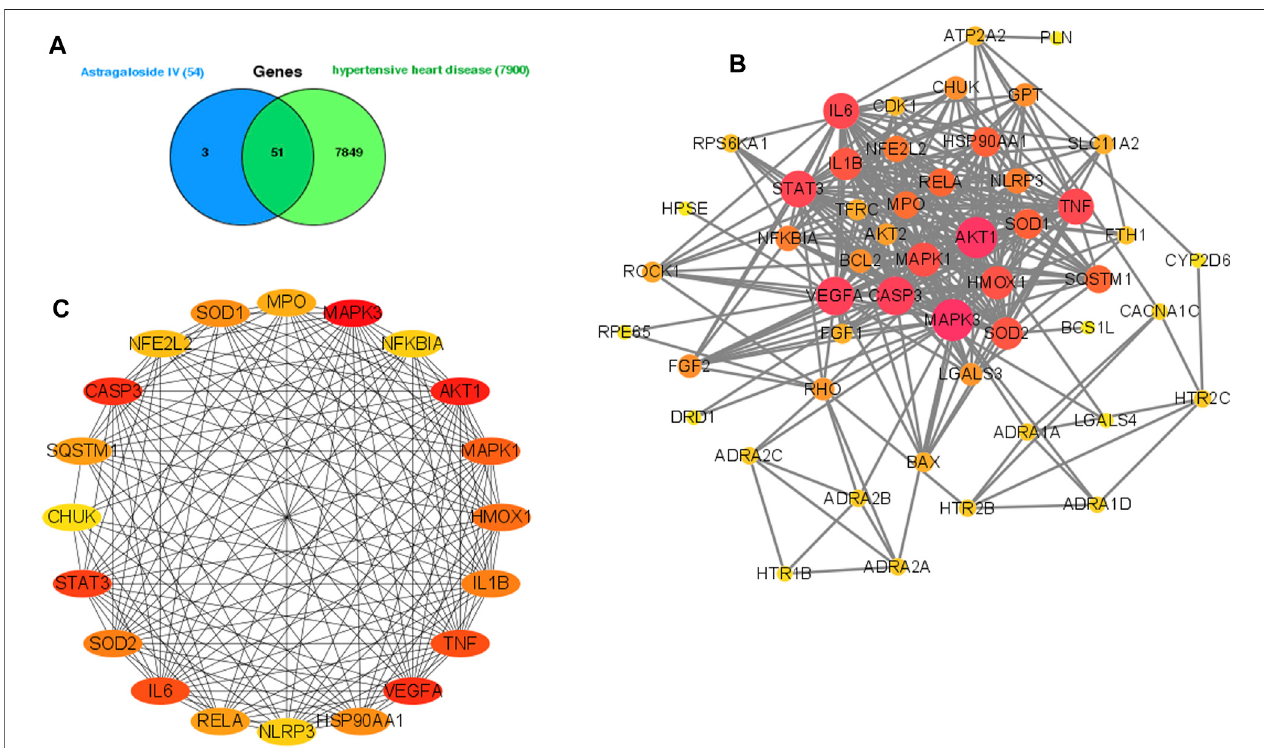
FIGURE1| AnalysisofthepotentialgenesofAS-IVforthetreatment ofhypertensiveheartdisease.Venndiagramof51potentialcommongenes (A) .Construction of a PPI network of those common genes. (B) PPI network construction of hub genes (C) , the darker color means the more important in the network.